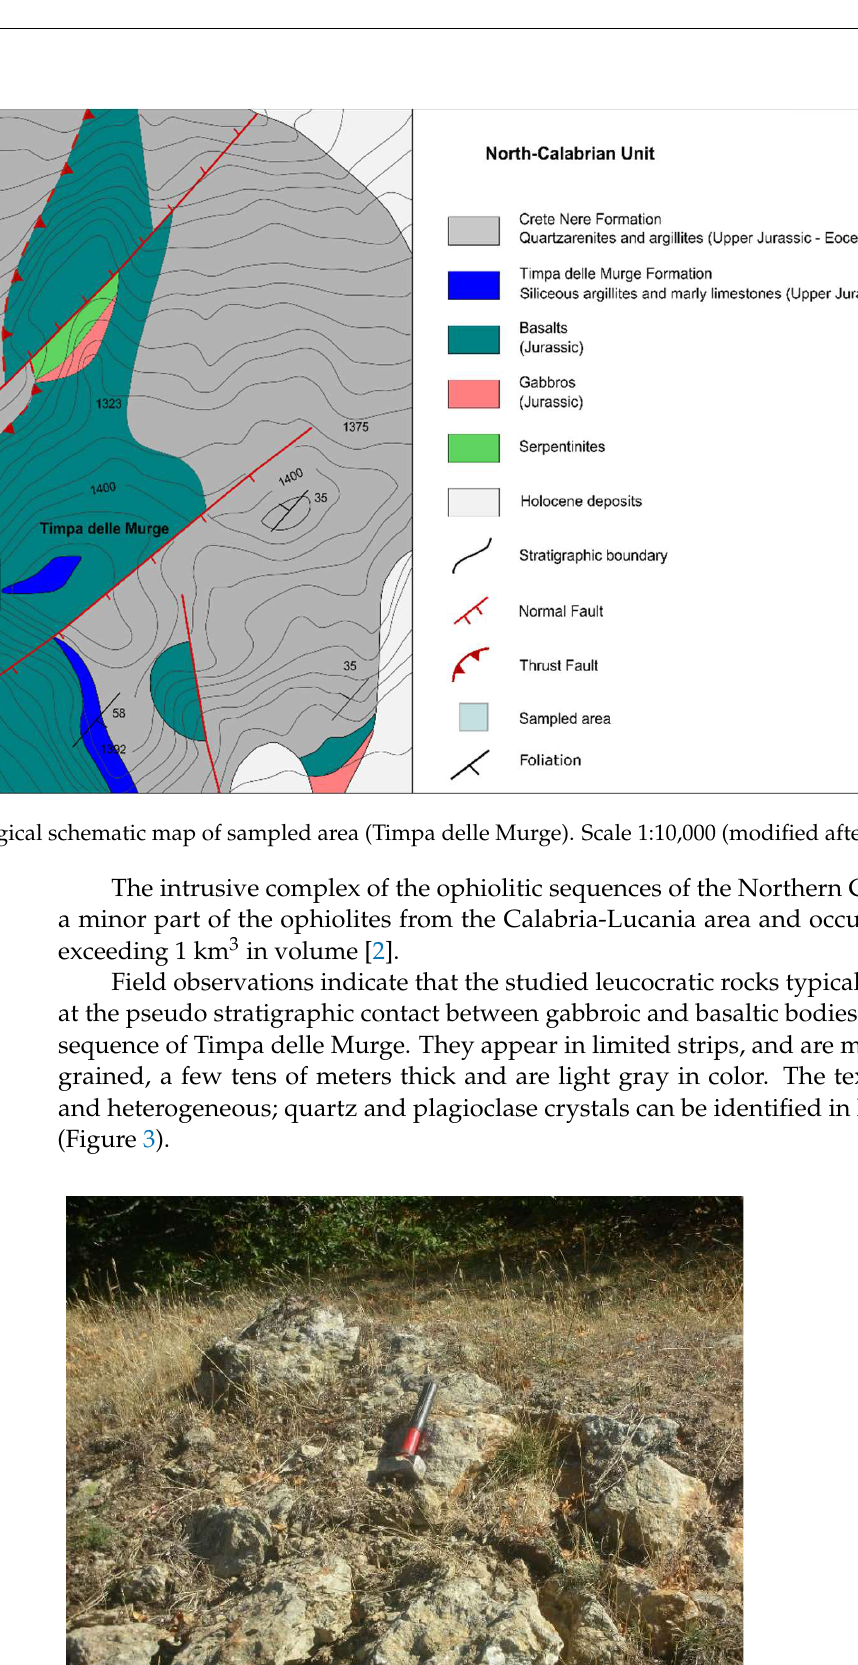
Figure 3. Occurrence of leucocratic rocks outcropping in the Timpa delle Murge area.